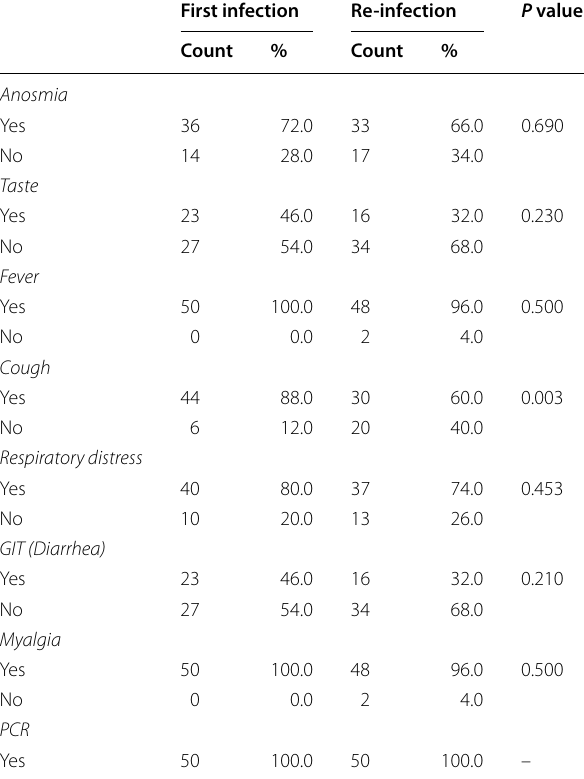
Table 3 Comparison between clinical symptoms presented during initial infection and re-infection First infection